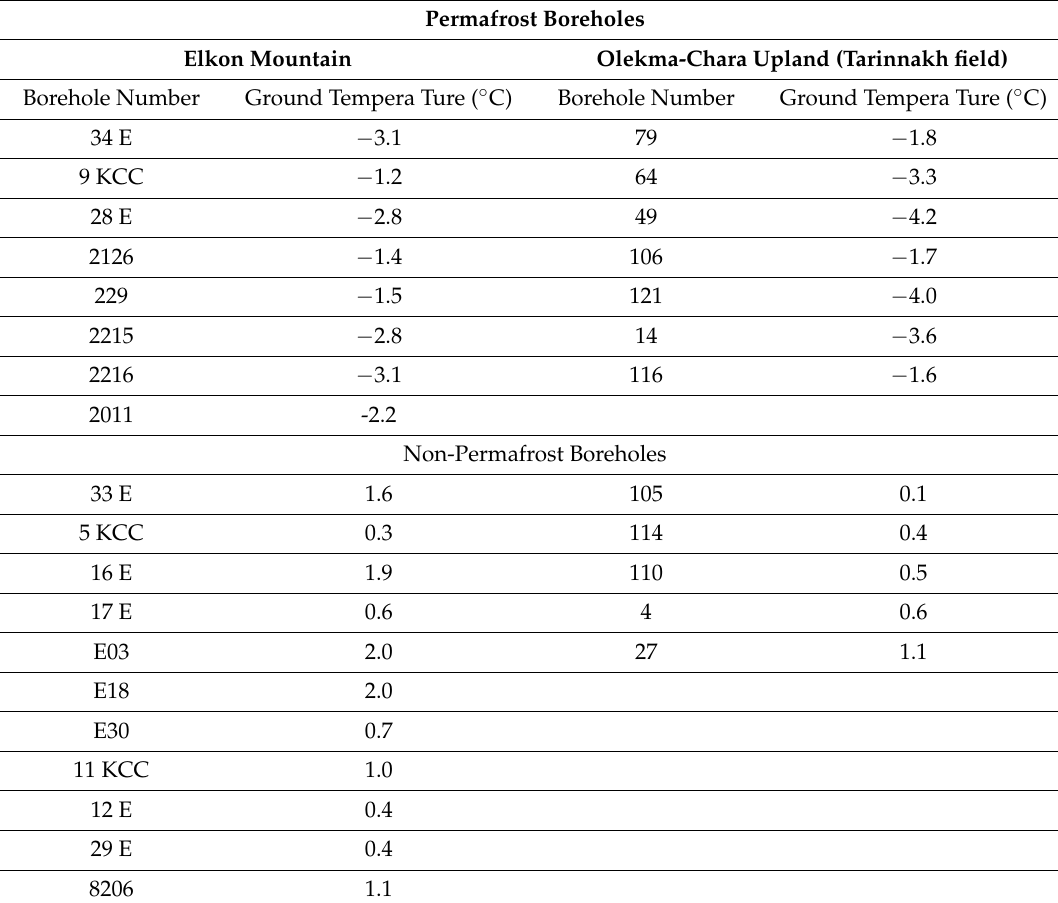
Table 1. Ground temperatures in boreholes (presented in map